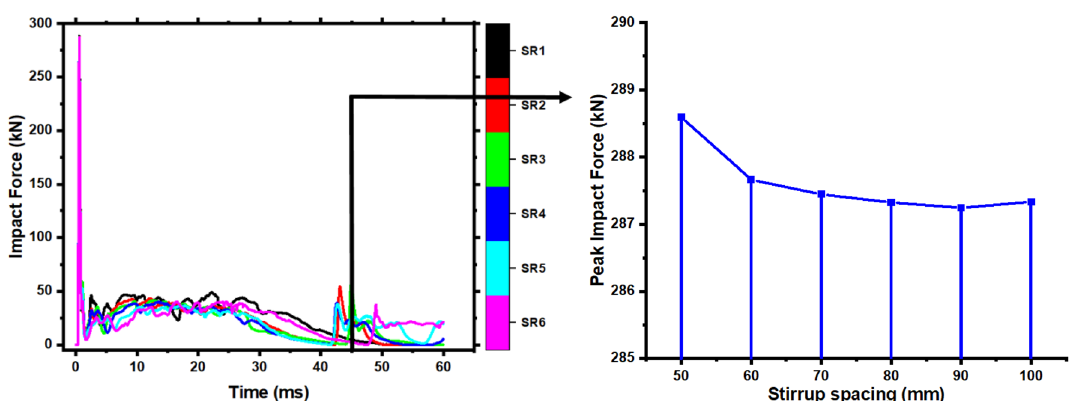
Figure 19. Peak and impact force–time history curve of members with various stirrup ratios.